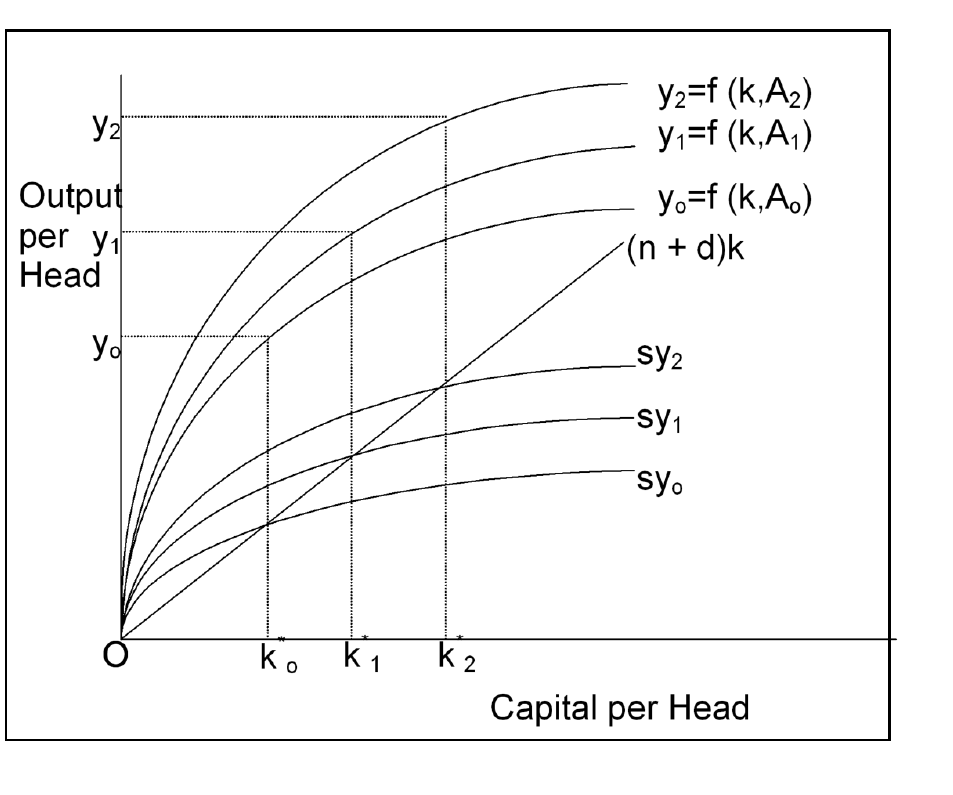
Figure 7. Isoquant